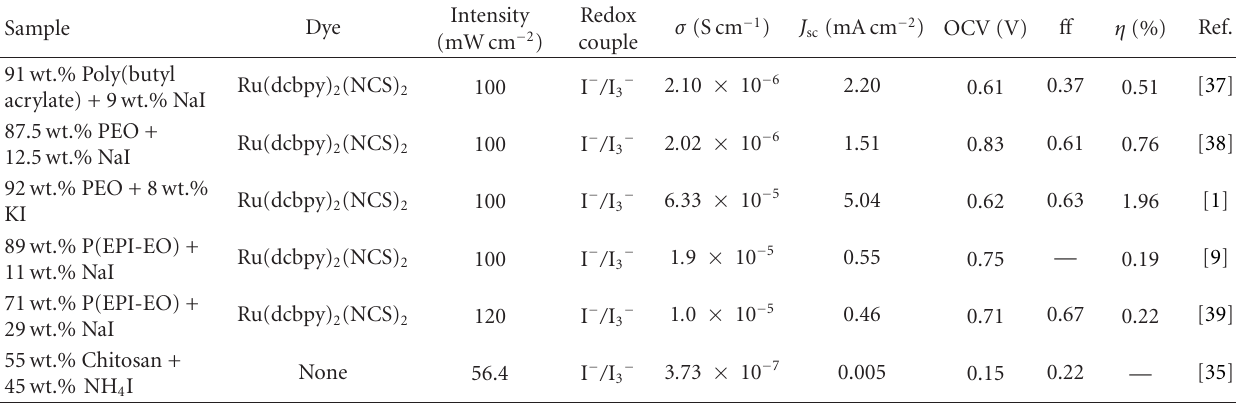
Table 2: Characteristics of PEC cells using polymer-salt systems.